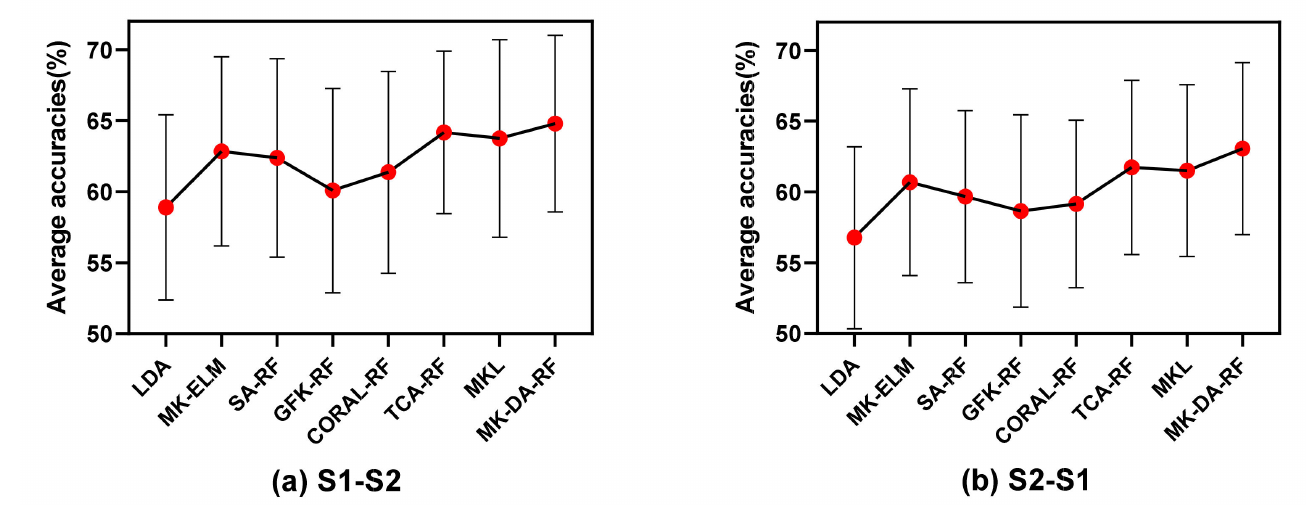
Figure 10. The results of the different distribution adaptation methods for the BI